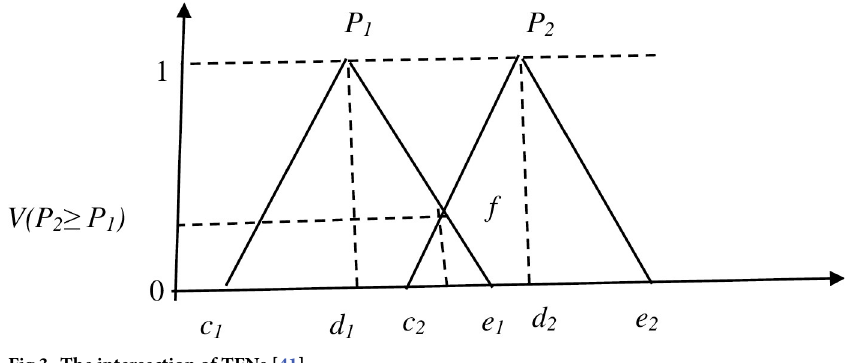
Fig 3. The intersection of TFNs